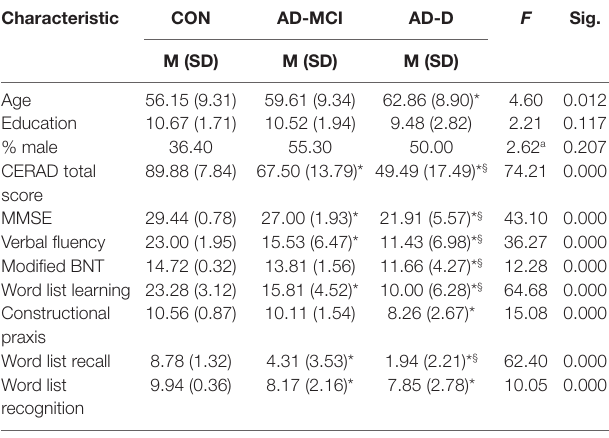
*Score differs significantly from CON group (p < 0.05). § Score differs significantly from MCI group (p < 0.05). a χ 2 value calculated with Kruskal–Wallis test. CON, healthy controls; AD-MCI, mild cognitive impairment due to Alzheimer’s disease; AD-D, dementia due to Alzheimer’s disease; CERAD, Consortium to Establish a Registry for Alzheimer’s disease; MMSE, Mini–Mental Status Exam; Modified BNT, Modified Boston Naming